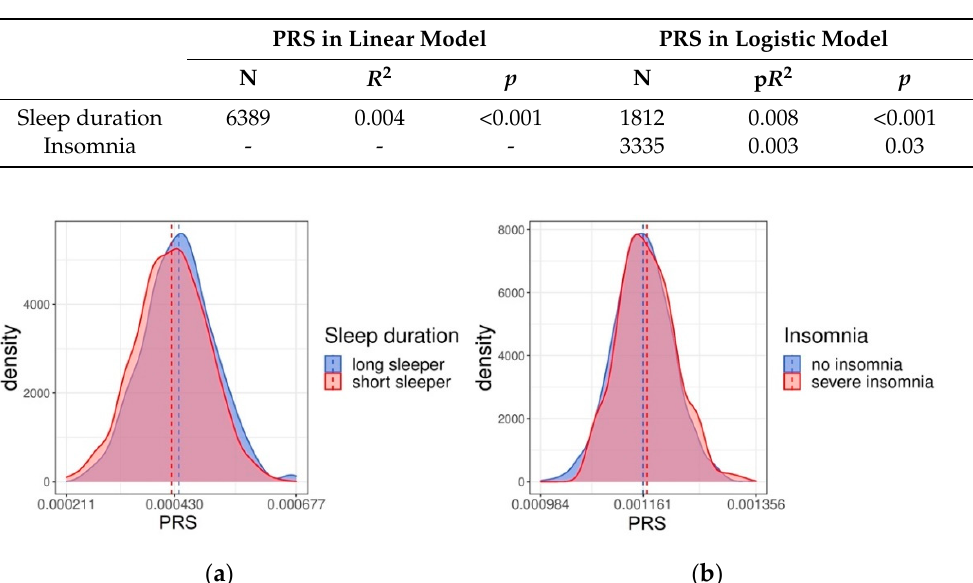
Table 2. Summary of the regression models for sleep duration and insomnia based on Health 2000/2011 participants. Dependent and independent variables are sleep traits and PRS, respectively. PRS = polygenic risk score, p R 2 = pseudo- R 2 .